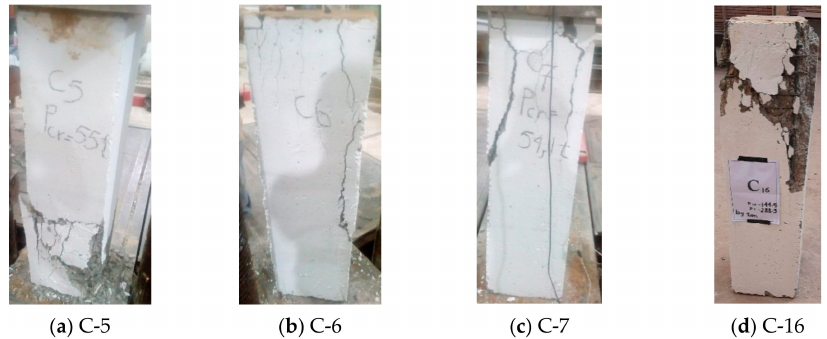
Figure 6. Crack patterns of the strengthened square RC